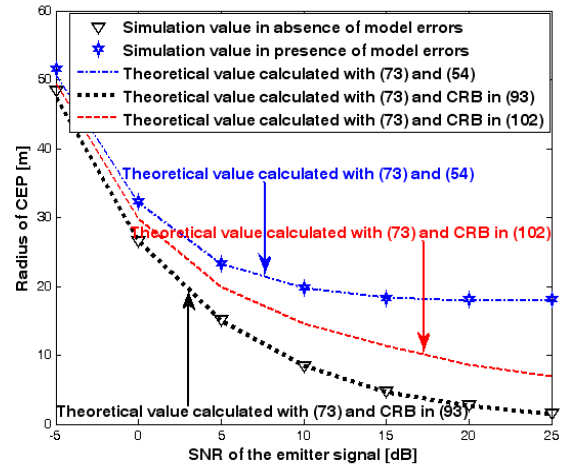
Figure 20. Radius of circular error probable (CEP) versus SNR of the emitter signal in the second experiment.